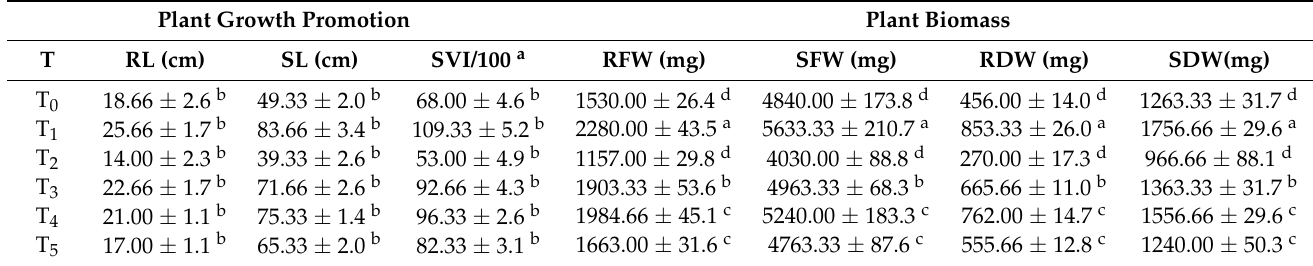
Table 8. In vivo growth promotion of chickpea plant by the strain A7 during the treatments with Fusarium oxysporum f. sp. ciceris